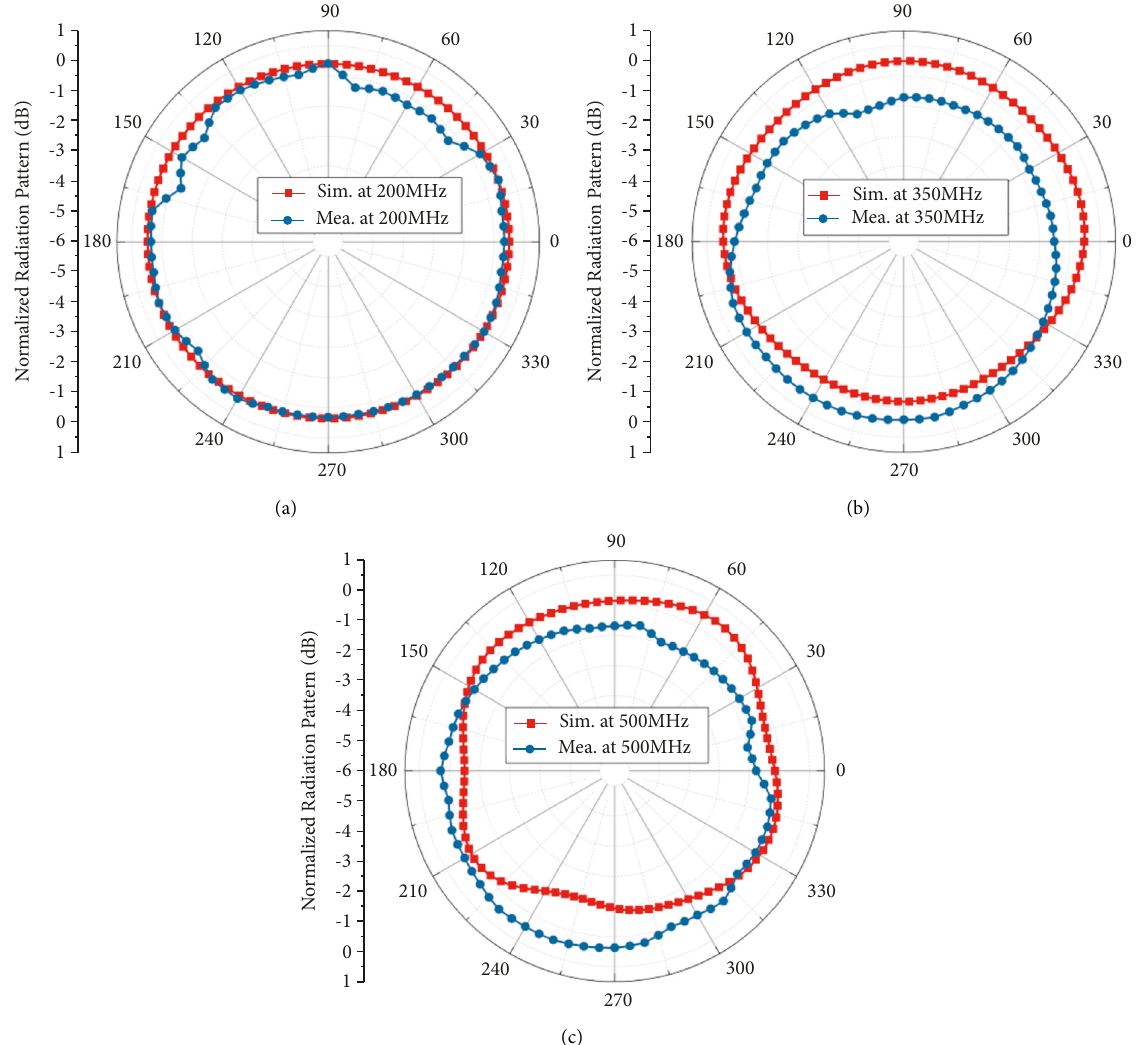
Figure 19: Simulated and measured normalized H-plane radiation patterns. (a) 200 MHz, (b) 350MHz, and (c)